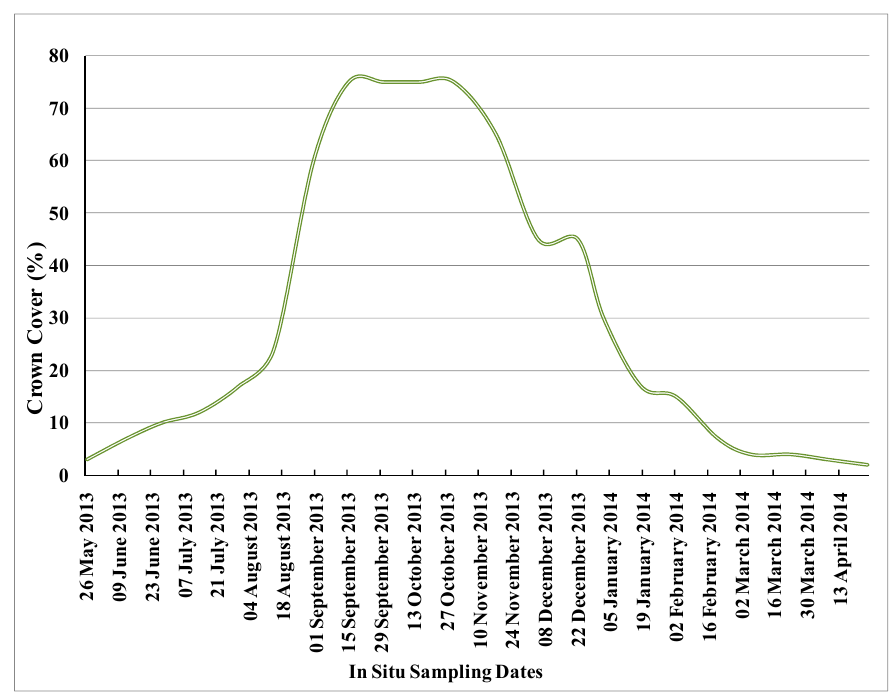
Figure 14. Crown cover in percentage during in situ sampling period.